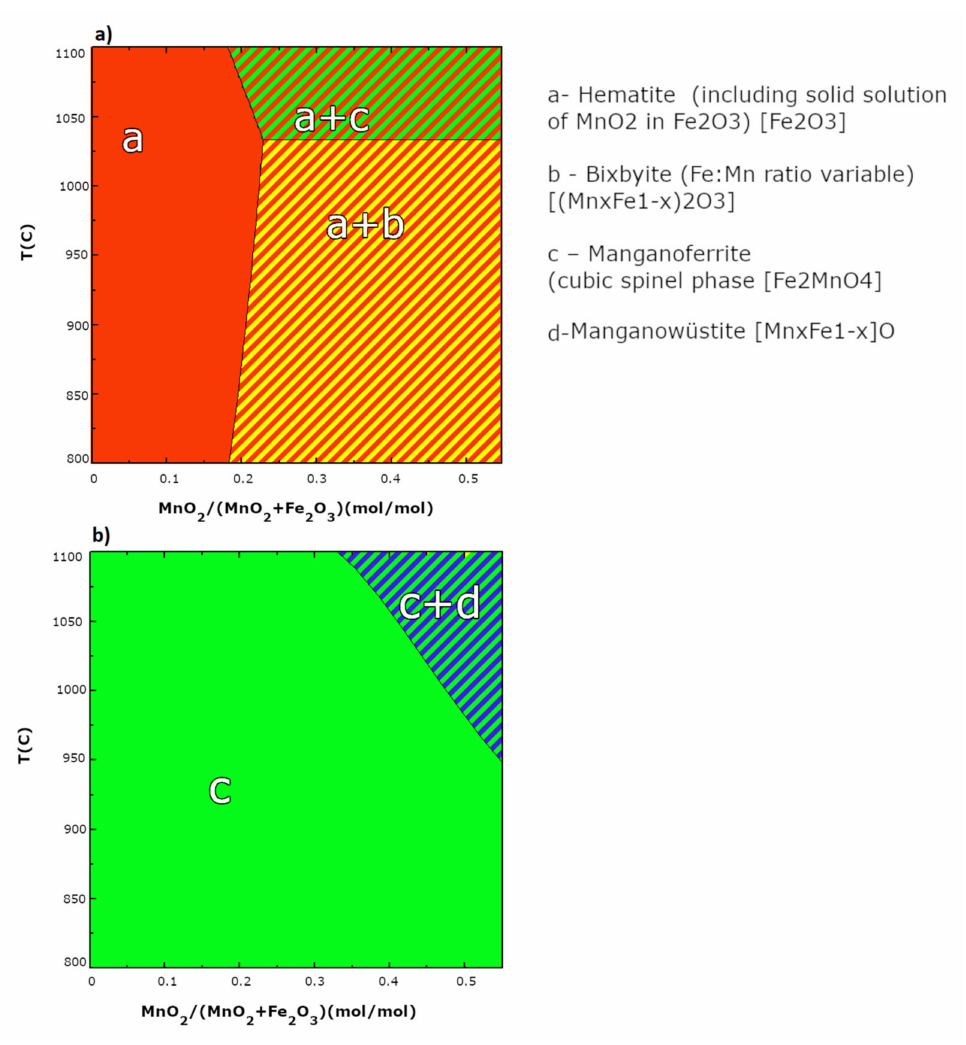
Figure 3. Calculated phase diagrams of Fe 2 O 3 -MnO 2 system: under oxygen partial pressure of 0.20 atm aerobic condition ( a ) and under anaerobic conditions ( b